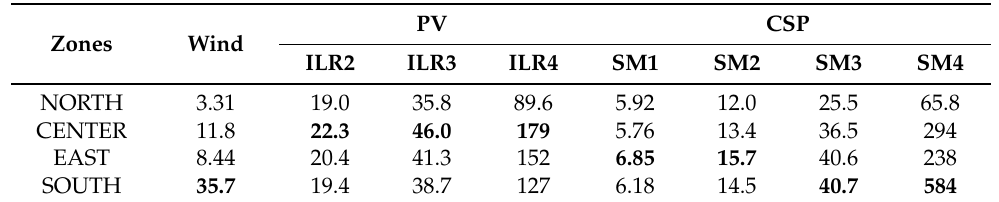
Table 9. Minimum-variance ratios (10 3 MW),